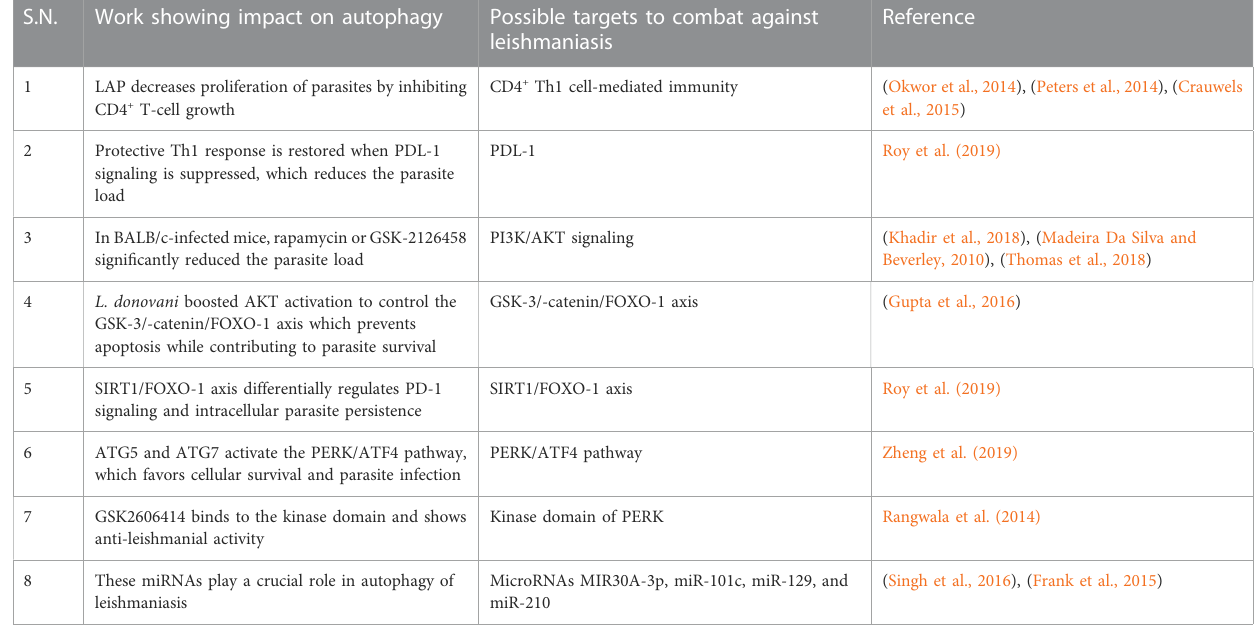
TABLE 4 Probable targets in the host for regulating the autophagy process in leishmaniasis and its impact on the fate of parasite.